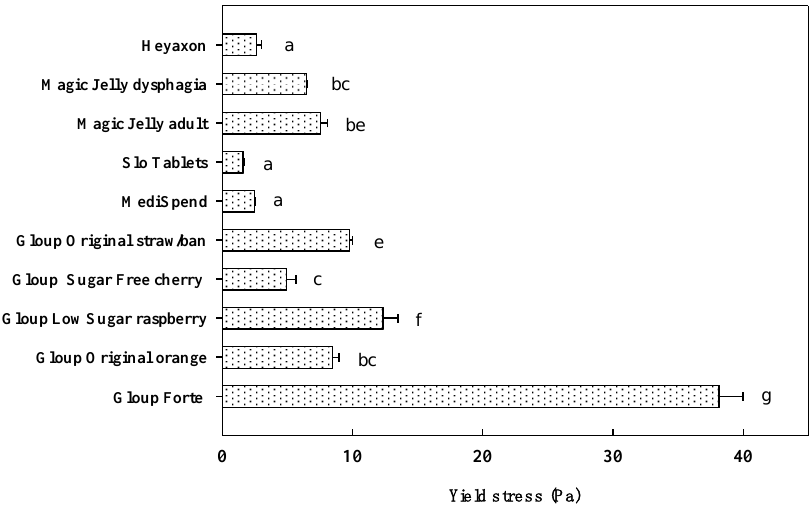
Figure 2. Yield stress values for medication lubricants measured across stress range 0.001–1000 Pa, at room temperature (24 °C). Significant difference ( p < 0.05) between mean values is indicated by unlike letters ( a–f ) above the bar.